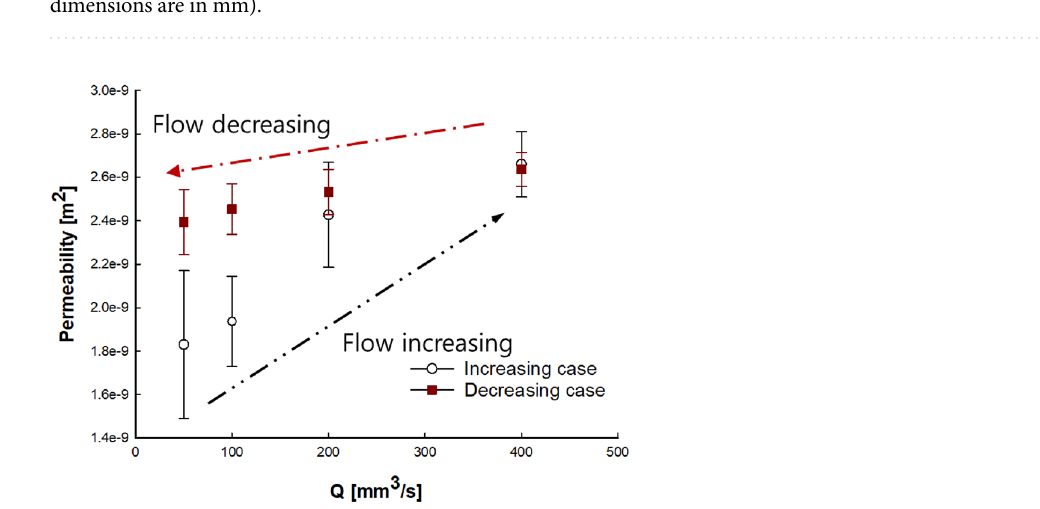
Figure 2. Schematic of experimental apparatus for observing tow behavior in double-scale porous media (all dimensions are in mm).